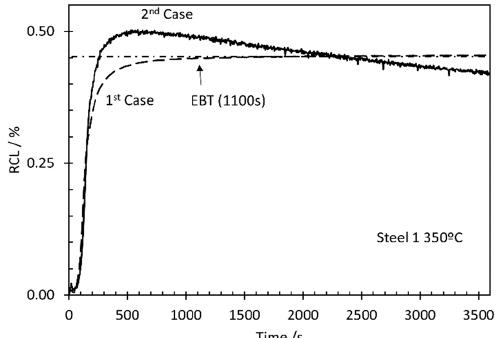
Figure 5. For Steel 1 treated at 350 °C, the relative change in length of two identical test leading to different dilatometric curves. Also marked is the end of the bainite transformation (EBT) obtained by means of Method I.